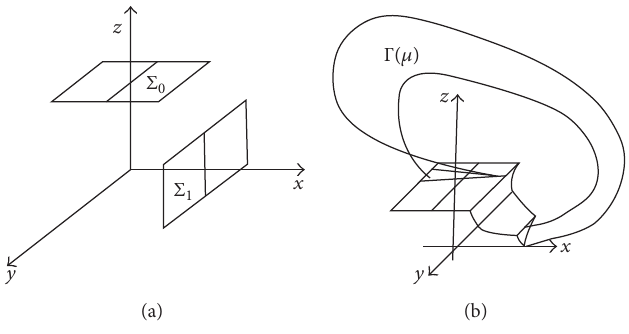
Figure 1: Poincar´e map of the Lorenz.